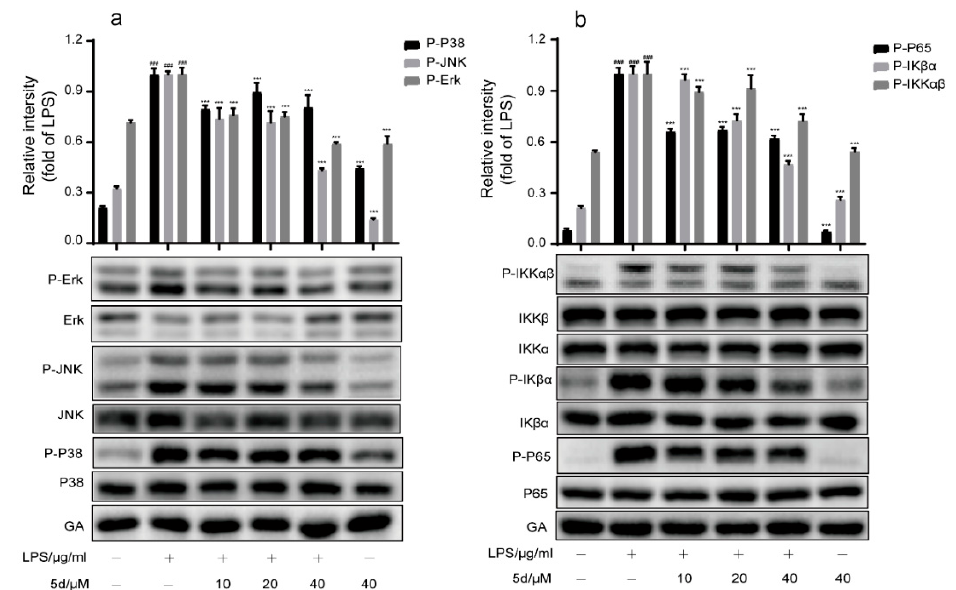
Figure 8. Effect of compound 5d on MAPK( a )/NF- κ B( b ) signaling pathway. ( a,b ) RAW264.7 cells were pretreated with 5d for 1 h, then co-cultured with LPS (1 µ g/mL) for another 6 h. The expression levels of p-ERK, p-P38, p-JNK, p-P65, p-IK βα and p-IKK αβ were determined by Western blotting. All the experiments were independently performed three times. *** p < 0.001 compared with the LPS group; ### p < 0.001, compared with control group.